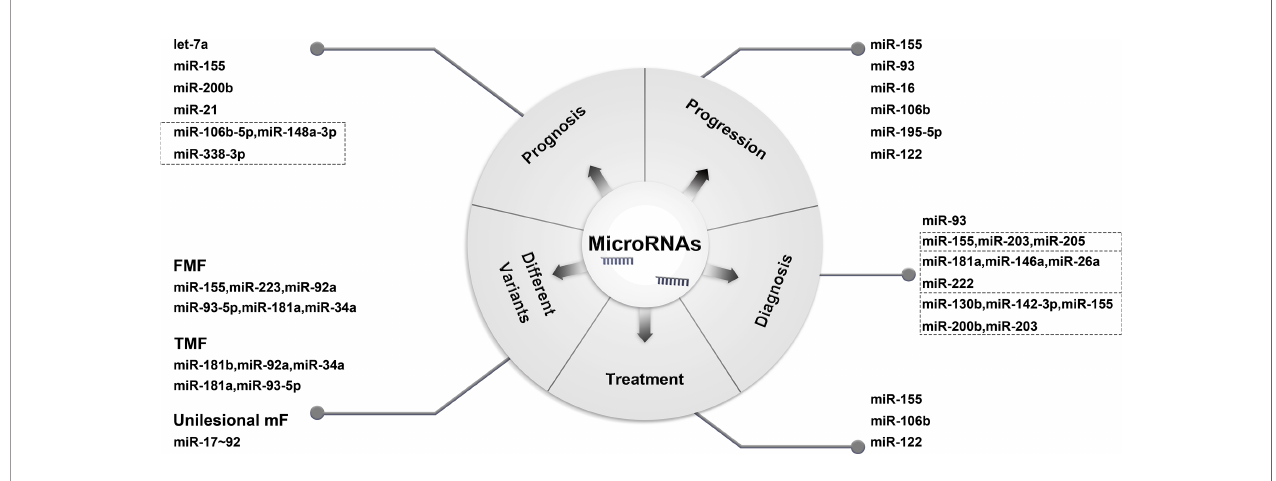
FIGURE 1 | Functions of miR in